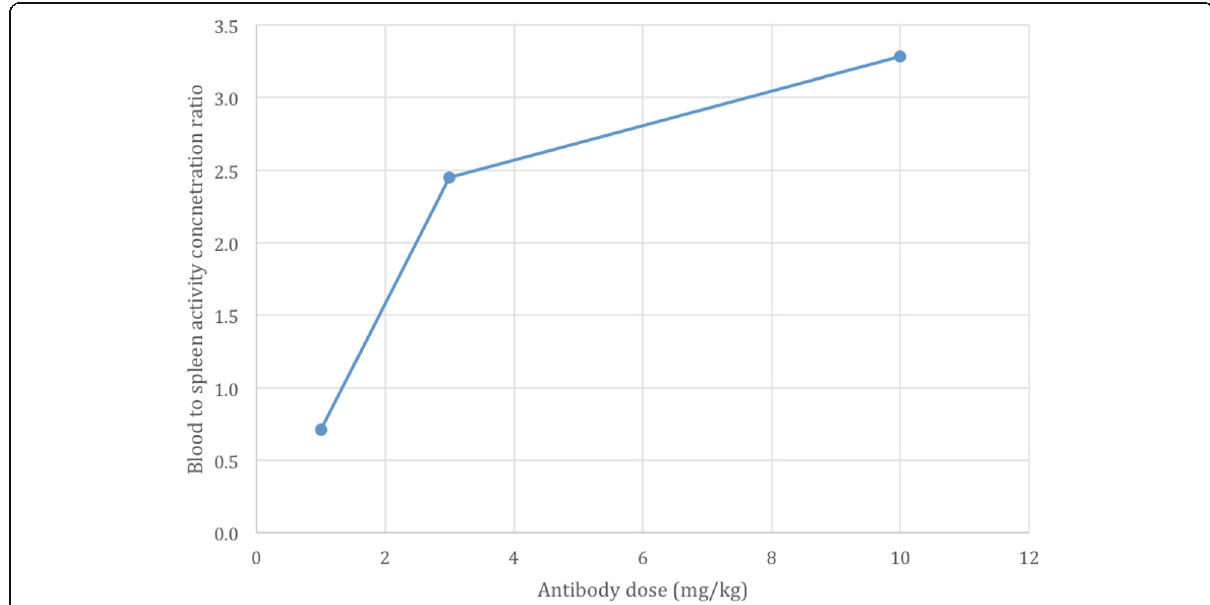
Fig. 14 Impact of protein dose blood to spleen activity concentration ratio at 6 h post-injection of 111